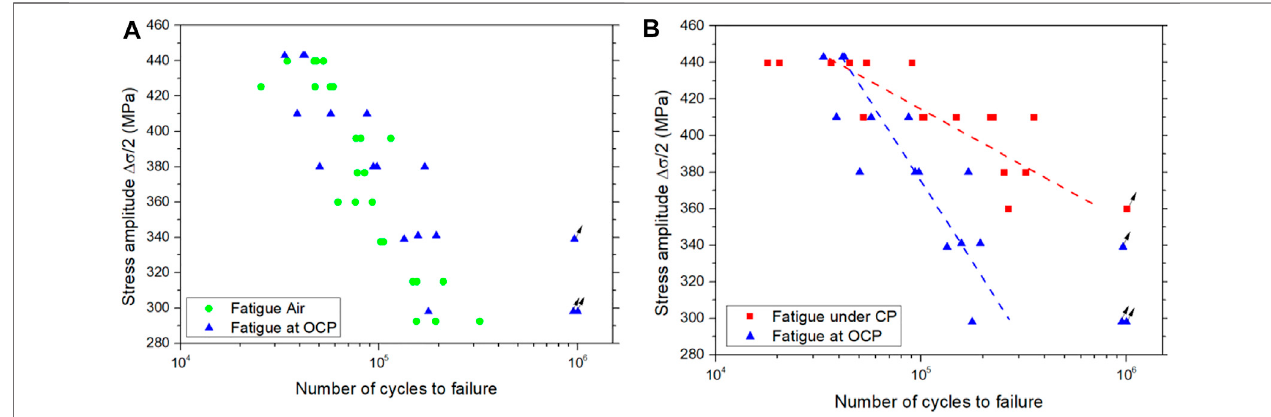
FIGURE 6 | Comparison of the fatigue lives of SDSS 1 (A) in air and in natural seawater at OCP and (B) at OCP and under CP at − 1,100 mV/SCE. Runouts ( > 1M cycles) are indicated by arrows.